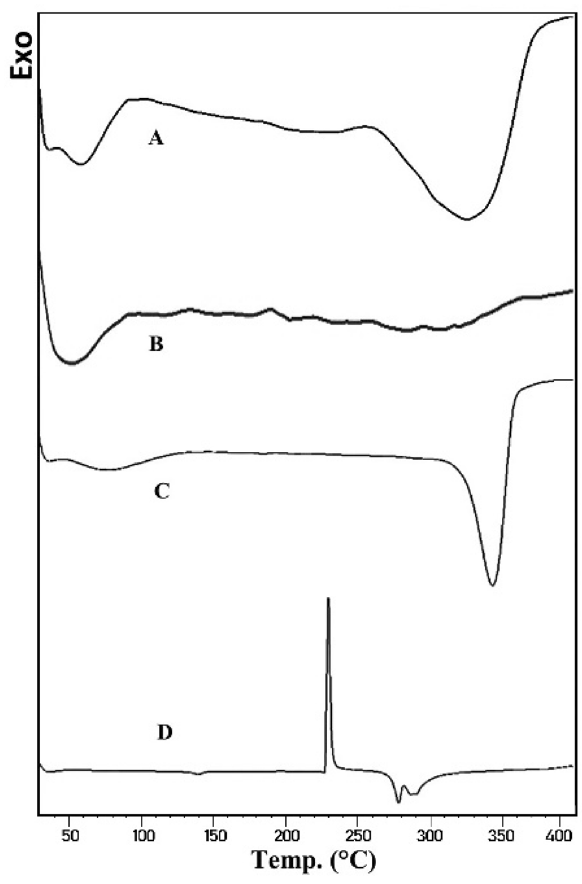
Figure 4. DSC thermograms of: (A) LS powder, (B) Aerosil 200, (C) Avicel PH101, (D)